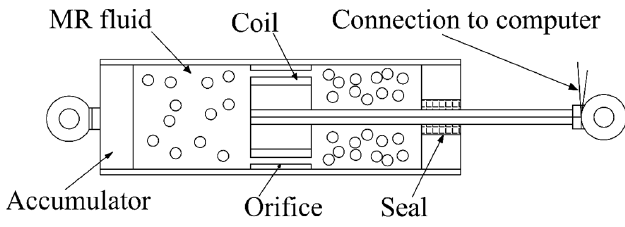
Figure 13. Schematics of an MR damper.